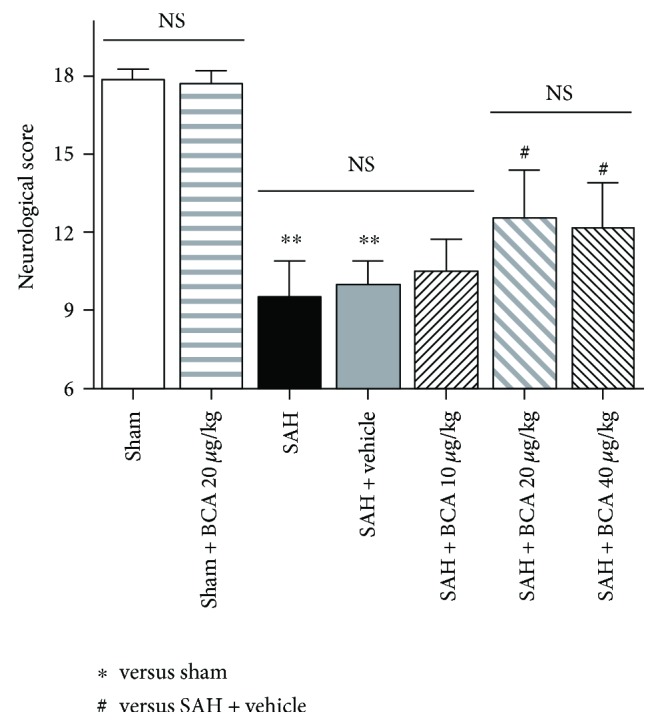
The effects of BCA on neurological function at 24-hour post-SAH rats and sham rats. (n = 6, each group; ∗∗P < 0.01 versus sham; #P < 0.05 versus SAH + vehicle; NSP > 0.05).